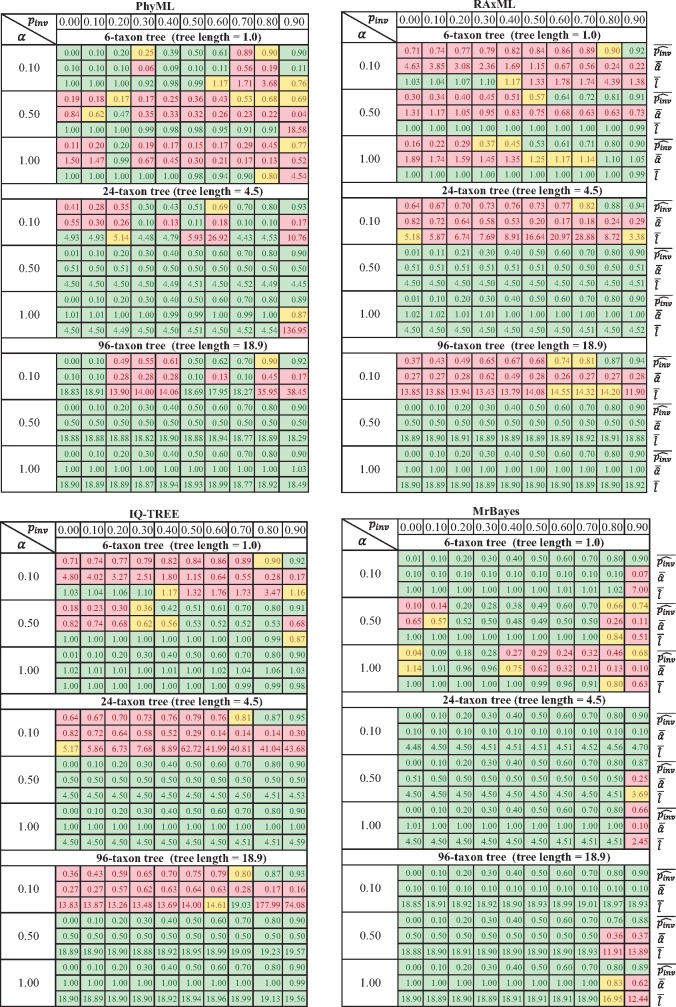
The averages \documentclass[12pt]{minimal}
\usepackage{amsmath}
\usepackage{wasysym} 
\usepackage{amsfonts} 
\usepackage{amssymb} 
\usepackage{amsbsy}
\usepackage{upgreek}
\usepackage{mathrsfs}
\setlength{\oddsidemargin}{-69pt}
\begin{document}
}{}$\bar{\hat{\alpha }}$\end{document} of the estimated shape parameter \documentclass[12pt]{minimal}
\usepackage{amsmath}
\usepackage{wasysym} 
\usepackage{amsfonts} 
\usepackage{amssymb} 
\usepackage{amsbsy}
\usepackage{upgreek}
\usepackage{mathrsfs}
\setlength{\oddsidemargin}{-69pt}
\begin{document}
}{}$\alpha $\end{document}, the averages \documentclass[12pt]{minimal}
\usepackage{amsmath}
\usepackage{wasysym} 
\usepackage{amsfonts} 
\usepackage{amssymb} 
\usepackage{amsbsy}
\usepackage{upgreek}
\usepackage{mathrsfs}
\setlength{\oddsidemargin}{-69pt}
\begin{document}
}{}$\overline{\widehat{p_{inv}}}$\end{document} of the estimated invariable fraction \documentclass[12pt]{minimal}
\usepackage{amsmath}
\usepackage{wasysym} 
\usepackage{amsfonts} 
\usepackage{amssymb} 
\usepackage{amsbsy}
\usepackage{upgreek}
\usepackage{mathrsfs}
\setlength{\oddsidemargin}{-69pt}
\begin{document}
}{}$p_{\rm inv}$\end{document} and the average \documentclass[12pt]{minimal}
\usepackage{amsmath}
\usepackage{wasysym} 
\usepackage{amsfonts} 
\usepackage{amssymb} 
\usepackage{amsbsy}
\usepackage{upgreek}
\usepackage{mathrsfs}
\setlength{\oddsidemargin}{-69pt}
\begin{document}
}{}$\bar{\hat{l}}$\end{document} of the estimated tree length \documentclass[12pt]{minimal}
\usepackage{amsmath}
\usepackage{wasysym} 
\usepackage{amsfonts} 
\usepackage{amssymb} 
\usepackage{amsbsy}
\usepackage{upgreek}
\usepackage{mathrsfs}
\setlength{\oddsidemargin}{-69pt}
\begin{document}
}{}$l$\end{document} produced by PhyML, RAxML, IQ-TREE, and MrBayes for the 100 alignments simulated from each parameter combinations. The averages are highlighted according to their differences from the true values: inaccurate (more than 25% deviation, red in online version), moderately inaccurate (10% to 25% deviation yellow in online version), and accurate (less than 10% deviation green in online version). For \documentclass[12pt]{minimal}
\usepackage{amsmath}
\usepackage{wasysym} 
\usepackage{amsfonts} 
\usepackage{amssymb} 
\usepackage{amsbsy}
\usepackage{upgreek}
\usepackage{mathrsfs}
\setlength{\oddsidemargin}{-69pt}
\begin{document}
}{}$p_{\rm inv}=0.0$\end{document} the estimated \documentclass[12pt]{minimal}
\usepackage{amsmath}
\usepackage{wasysym} 
\usepackage{amsfonts} 
\usepackage{amssymb} 
\usepackage{amsbsy}
\usepackage{upgreek}
\usepackage{mathrsfs}
\setlength{\oddsidemargin}{-69pt}
\begin{document}
}{}$\overline{\widehat{p_{inv}}}$\end{document} is accurate if \documentclass[12pt]{minimal}
\usepackage{amsmath}
\usepackage{wasysym} 
\usepackage{amsfonts} 
\usepackage{amssymb} 
\usepackage{amsbsy}
\usepackage{upgreek}
\usepackage{mathrsfs}
\setlength{\oddsidemargin}{-69pt}
\begin{document}
}{}$0\leqslant \overline{\widehat{p_{inv}}}\leqslant 0.01$\end{document}, moderately inaccurate if \documentclass[12pt]{minimal}
\usepackage{amsmath}
\usepackage{wasysym} 
\usepackage{amsfonts} 
\usepackage{amssymb} 
\usepackage{amsbsy}
\usepackage{upgreek}
\usepackage{mathrsfs}
\setlength{\oddsidemargin}{-69pt}
\begin{document}
}{}$0.01< \overline{\widehat{p_{inv}}} \leqslant 0.05$\end{document}, and inaccurate if \documentclass[12pt]{minimal}
\usepackage{amsmath}
\usepackage{wasysym} 
\usepackage{amsfonts} 
\usepackage{amssymb} 
\usepackage{amsbsy}
\usepackage{upgreek}
\usepackage{mathrsfs}
\setlength{\oddsidemargin}{-69pt}
\begin{document}
}{}$0.05< \overline{\widehat{p_{inv}}}$\end{document}.